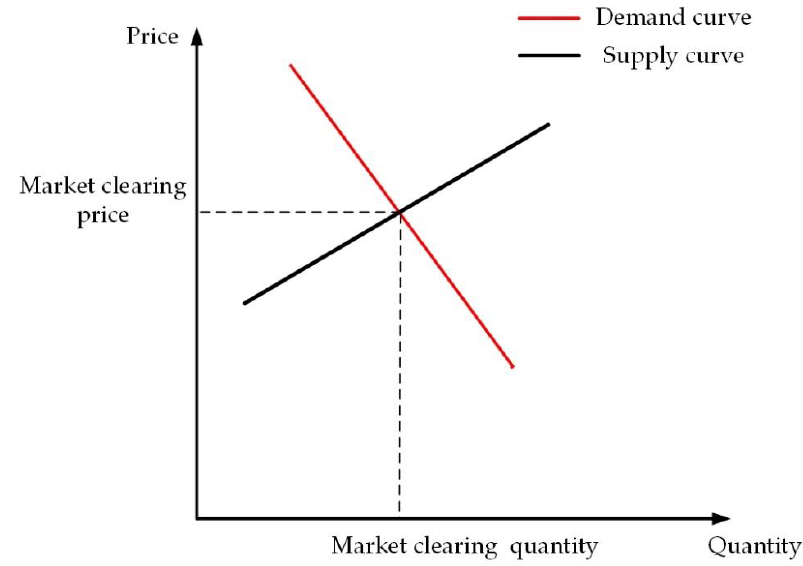
Figure 2. Schematic of the market clearing.